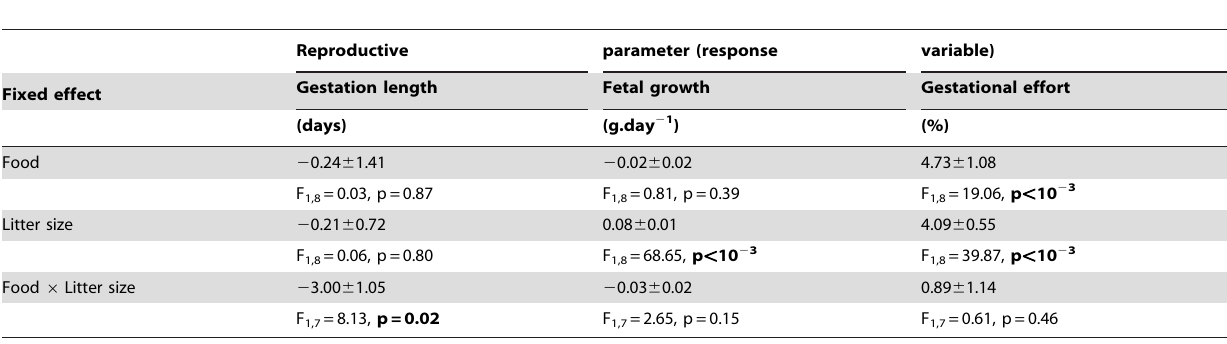
Table 4. Effect of food availability to mothers (Food effect: females fed ad libitum or exposed to a 40% chronic caloric restriction) and of litter size on gestation length, fetal growth and gestational effort (N =11 females from Experiment 1).